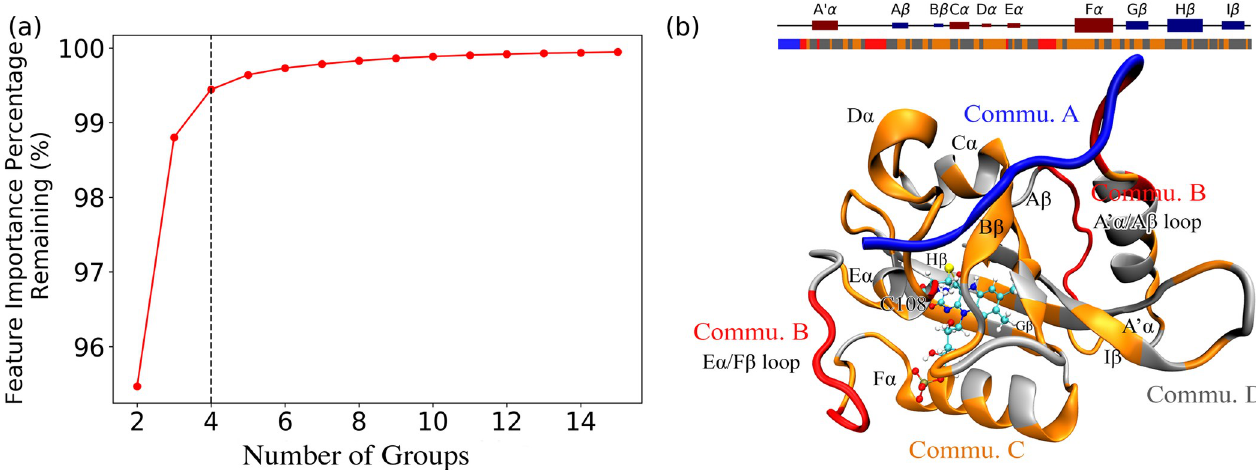
Fig 9. Community analysis of VVD based on one-vs-one random forest model. (a) Total feature importance among ML communities with regard to different number of communities; (b) Four ML communities named Commu. A, Commu. B, Commu. C and Commu. D as blue, red, yellow and grey colors, respectively. The ultimate number of ML communities is determined as four based on the elbow criterion. The feature importance across different ML communities accounts for 99.44% of total importance. The feature importance between Commu. A (which is mainly N-terminus) and the rest of protein accounts for 89.415%. The feature importance between Commu. B and Commu. C as well as D accounts for 9.103% of total feature importance.